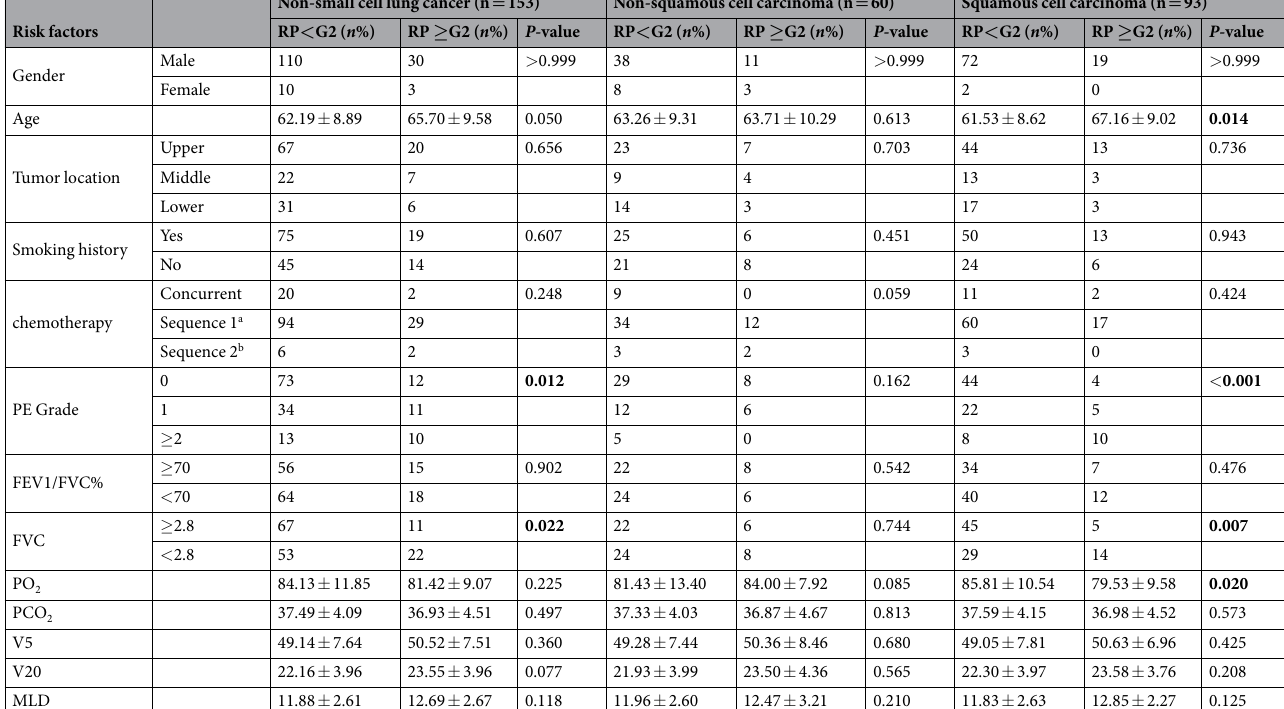
Table 2. Univariate analysis of possible risk factors associated with the development of Grade ≥ 2 RP. RP: radiation pneumonitis; G2, grade 2; G3, grade 3; PE, pulmonary emphysema; FEV1, forced expiratory volume in one second; FVC, forced vital capacity; PO 2 , arterial partial pressure of oxygen; PCO 2 , arterial partial